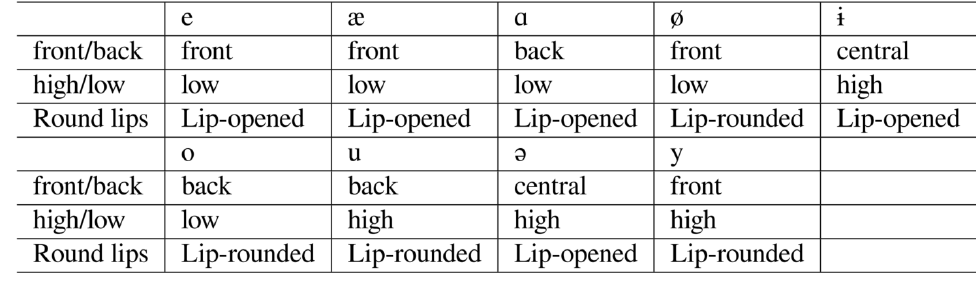
Figure A3. Kazakh vowels.